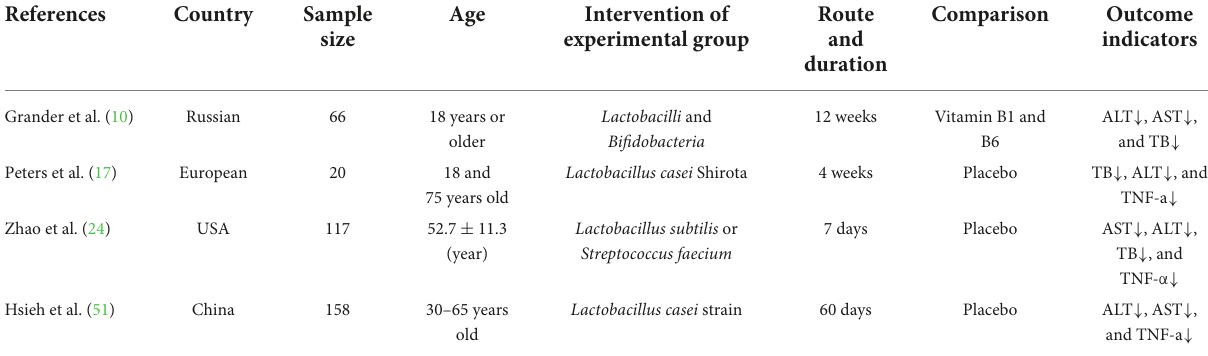
TABLE 2 Characteristics of included studies investigating the effects of probiotics and prebiotics on human